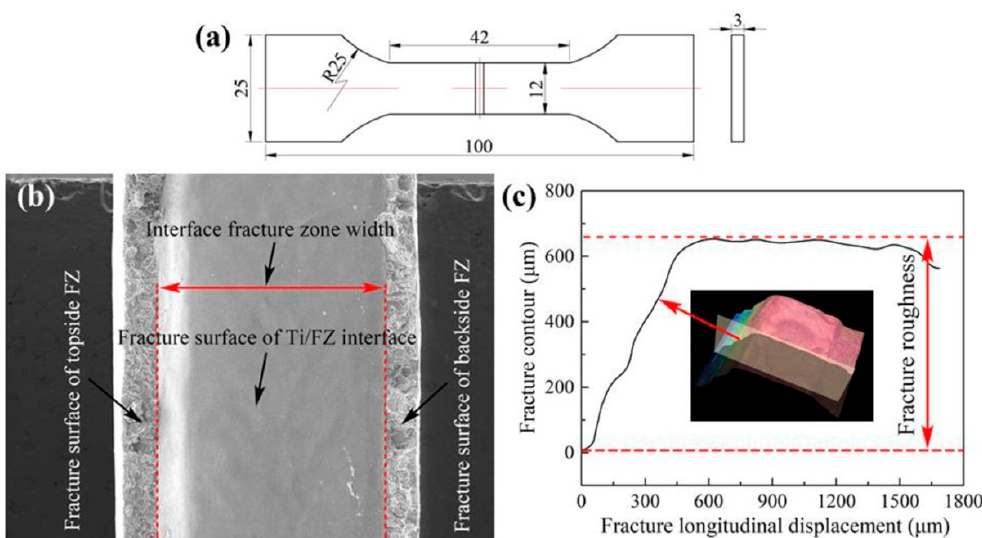
Figure 3. Tensile specimen characteristics: ( a ) 2D drawing; ( b ) fracture surface; ( c ) definition of fracture roughness.